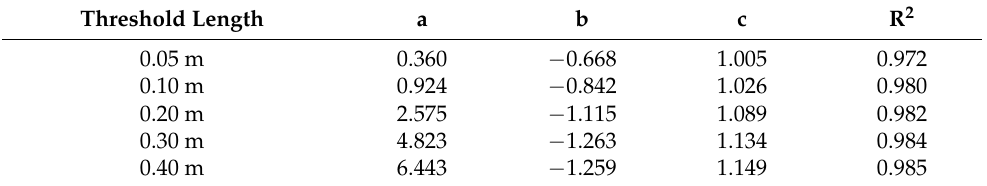
Table 1. Fitting parameters for Equation (15) of the power law in relationship to the threshold length. Threshold Length a b c R 2 0.05 m